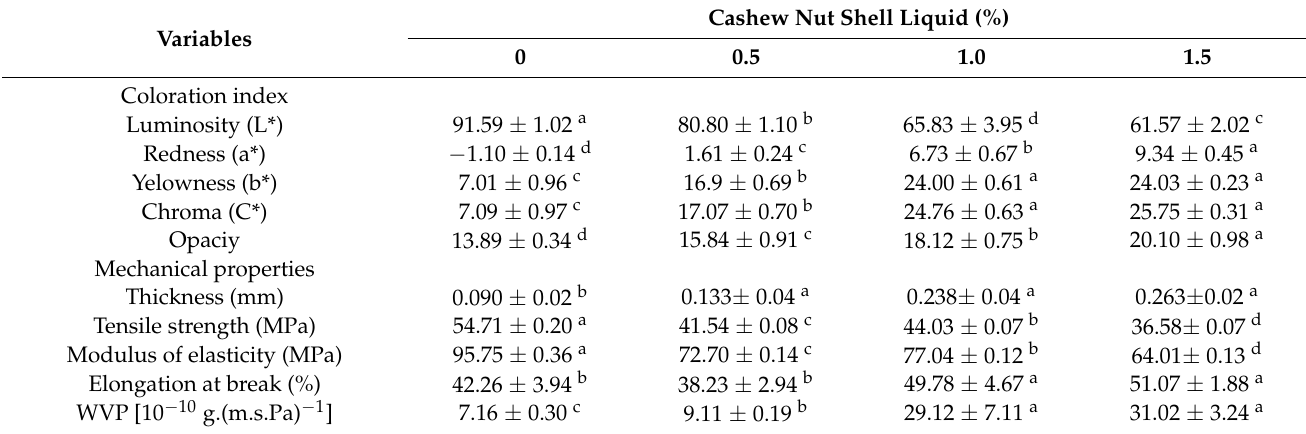
Table 1. Color parameters, mechanical properties, and water vapor permeability (WVP) of the bioactive films obtained from the incorporation of cashew nut shell liquid (CNSL) into a matrix of sodium alginate.